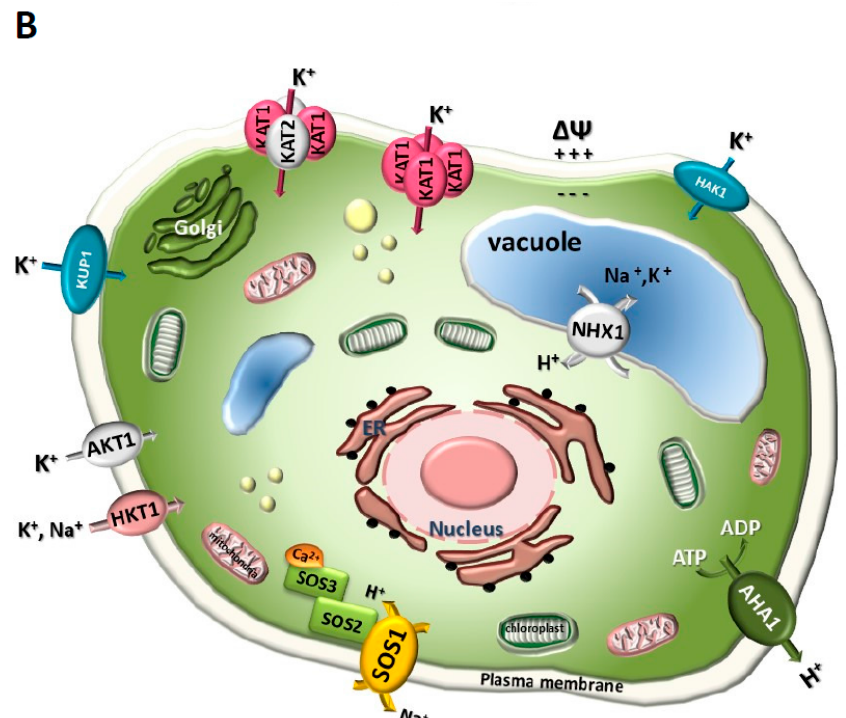
Figure 1. Schematic representation of the main monovalent channels and transporters in yeast and plant cells. ( A ) In a yeast cell, channels and transporters are present in almost all the organelles and cellular compartments. The introduction of positively charged ions and the expulsion of the negative ones maintains the negative plasma membrane potential. All the ion transporter proteins cited in the main text are represented. Inward/outward ion traffic is represented by arrows. ( B ) A schematic representation of a plant cell (without the cell wall). The KAT1 channel is represented in the known forms of homo-tetramer and hetero-tetramers with KAT2. All the transporters and channels cited in the text are represented. Organelle size is not to scale.